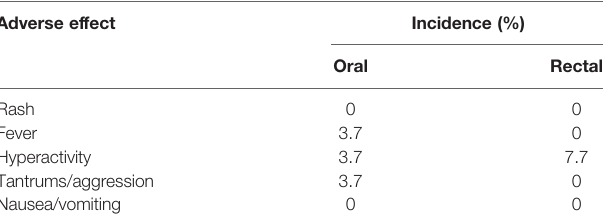
TABLE 3 | Adverse effects of oral and rectal administration.